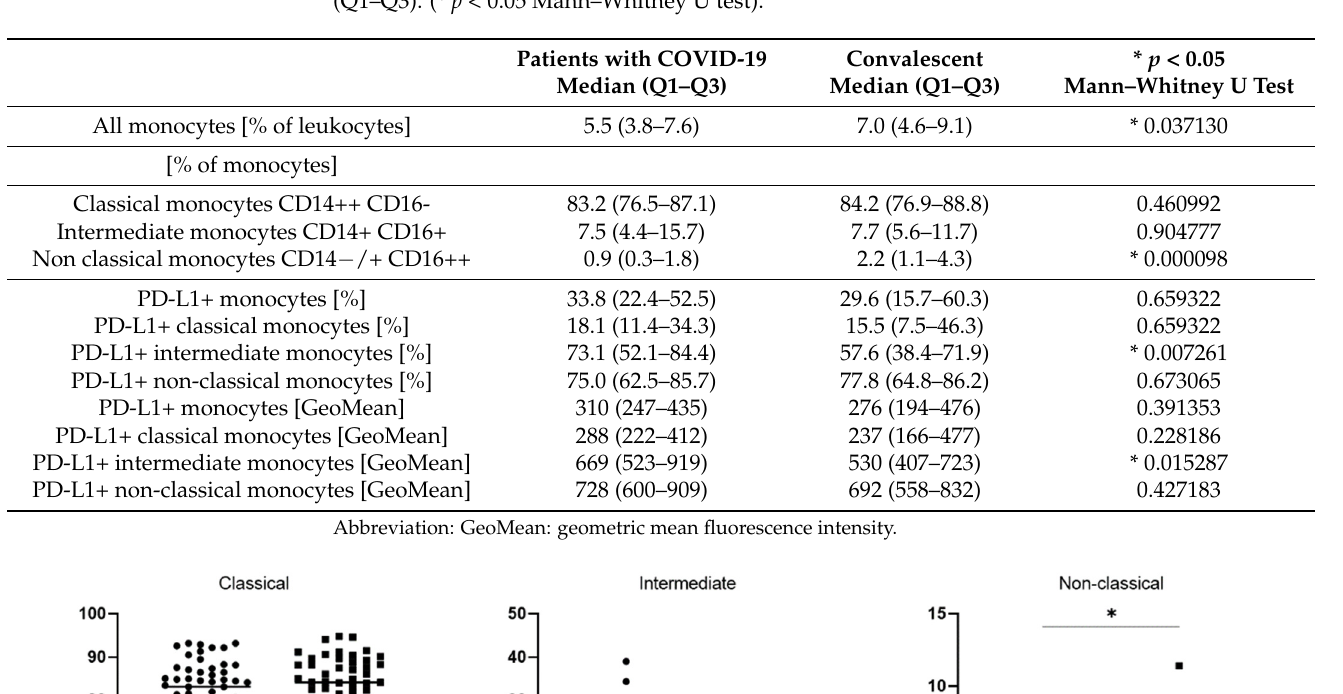
Table 3. Median proportion of three types of monocytes and monocyte subsets with PD-L1 expression between patients with COVID-19 and convalescent COVID-19 patients. Data expressed as median